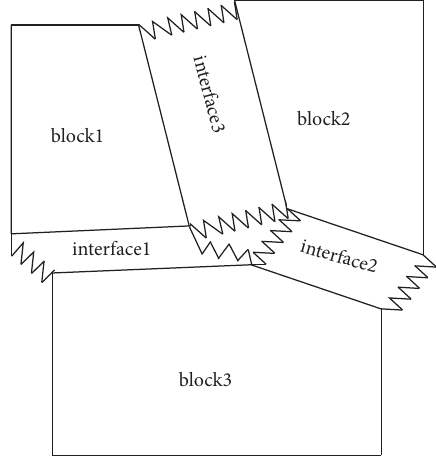
Figure 2: Blocks and interfaces in CDEM.